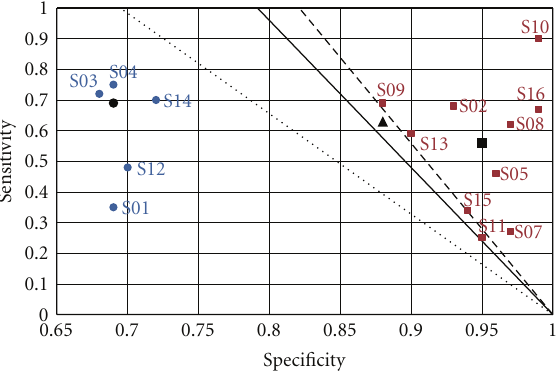
Figure 6: Error detection sensitivity as a function of error detection specificity. All subjects are represented as well as the global meta- subject (triangle) and the two metasubjects for the low specificity (circle) and high specificity (square) groups, respectively. The lines are the boundaries above which the automatic correction becomes fruitful, for the three groups (plain, dotted, and dashed,